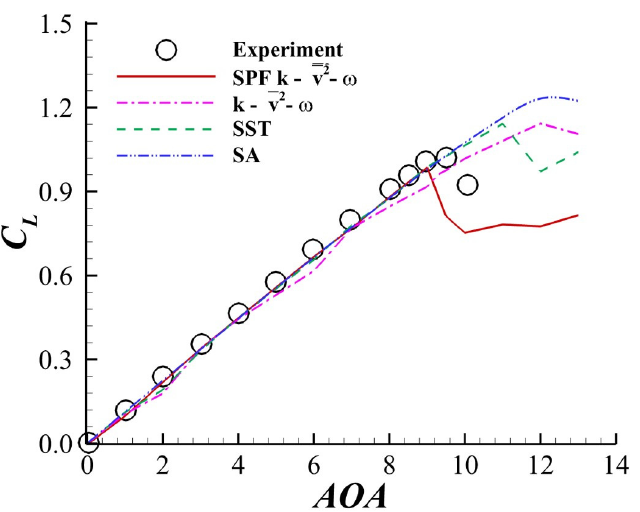
Figure 9. C L − AOA curve obtained by different turbulence models of NACA64A010 with Figure 9. 𝐶 (cid:3013) − 𝐴𝑂𝐴 curve obtained by different turbulence models of NACA64A010 with 𝑅𝑒 = Re = 4.1 × 10 6 and Ma = 0.167. The circles represent experiment data obtained by Peter- 4.1 × 10 (cid:2874) and 𝑀𝑎 = 0.167. The circles represent experiment data obtained by Peterson [34]. son [34].